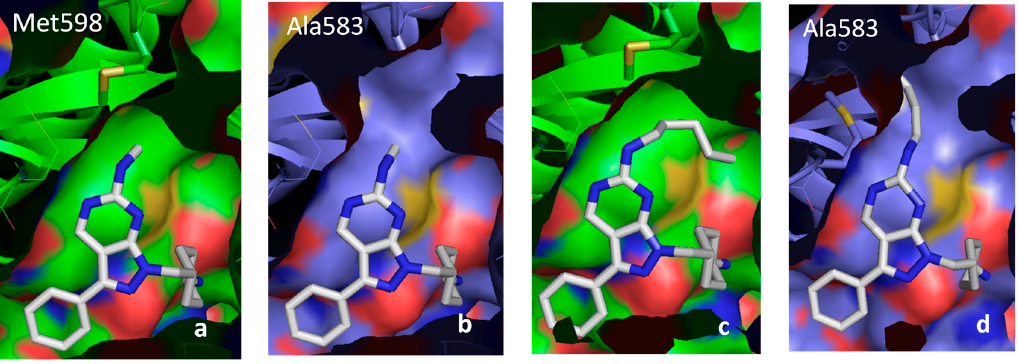
Figure 8. Docking of compounds 30 and 16 in the Axl and Tyro-3 models. Representation of the docking of compound 30 in the active site of the Axl model ( a ) and of the Tyro-3 model ( b ). Interaction of the pentylamine substituent of compound 16 with Met-598 in Axl ( c ), or with the hydrophobic pocket created by Ala-581, Ala-583, Pro-604, Met-606 and Ala-672 in the active site of the Tyro-3 model ( d